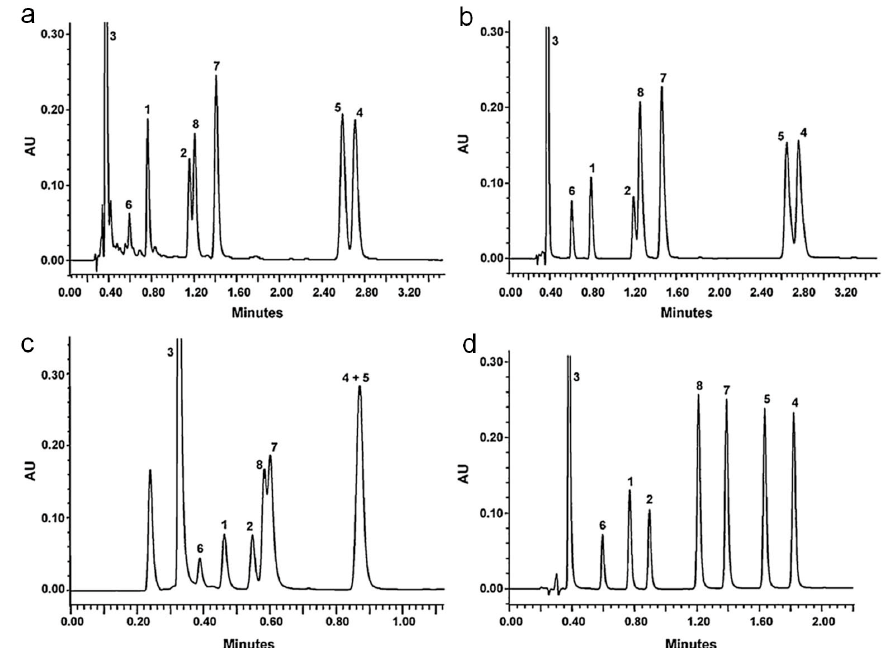
Figure 13. UPLC chromatograms obtained for analysis of eight flavanols with various RP columns packed with sub-2 μ m particles. ( a ) Acquity BEH C 18 (50 mm × 2.1mm ID, 1.7 μ m), ( b ), Hypersil GOLD (50 mm × 2.1 mm ID, 1.9 μ m), ( c ) Acquity BEH phenyl (50 mm × 2.1 mm ID, 1.7 μ m), and ( d ) Acquity BEH Shield RP18 (50 mm × 2.1 mm ID, 1.7 μ m). Peak assignation: (1) catechin, (2) epicatechin, (3) gallic acid, (4) catechin gallate, (5) epicatechin gallate, (6) epigallocatechin, (7) gallocatechin gallate, and (8) epigallocatechin gallate. Reproduced with permission from [68]. Copyright Elsevier, 2010.